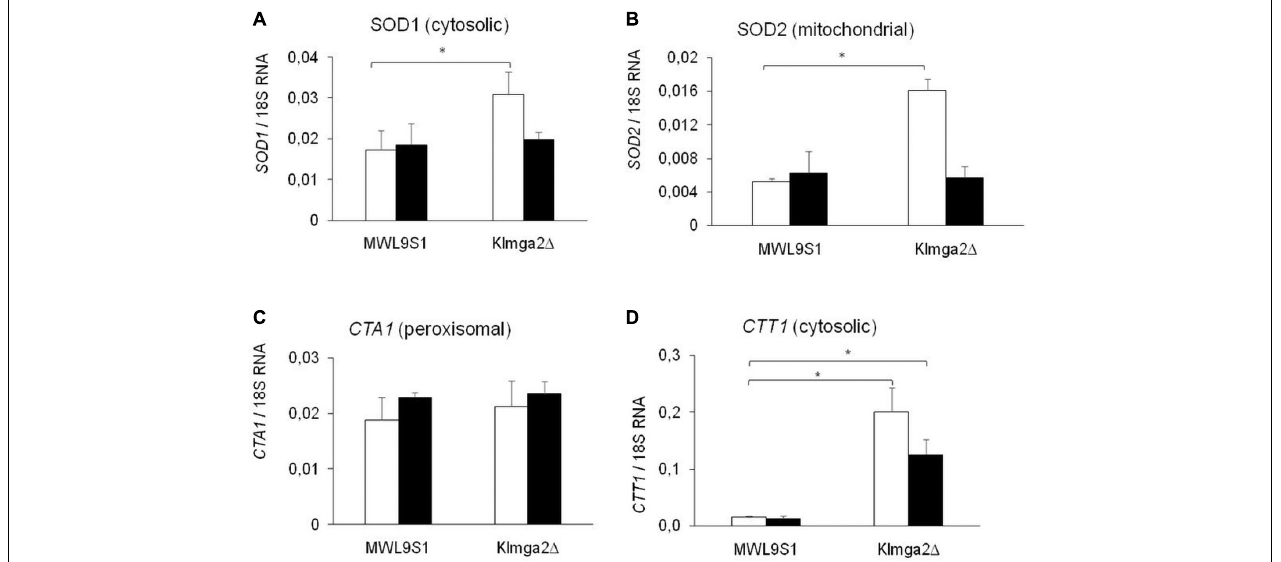
FIGURE 5 | Transcription of KlSOD1 , KlSOD2 , KlCTA1 , and KlCTT1 genes. Results of qRT-PCR analysis of Catalase (Cat) and SOD genes in wild type MWL9S1 and in Klmga2 (cid:49) mutant strain grown in YPD flask cultures in light (white blocks) or dark (black blocks) condition are reported. (A–D) report KlSOD1 , KlSOD2 , KlCTA1 , and KlCTT1 transcription analysis, respectively. Ribosomal 18S gene transcription has been used as reference. Values are averages of three independent determinations, each measured by two technical repetitions, with SD reported. ∗ indicates p < 0.05.